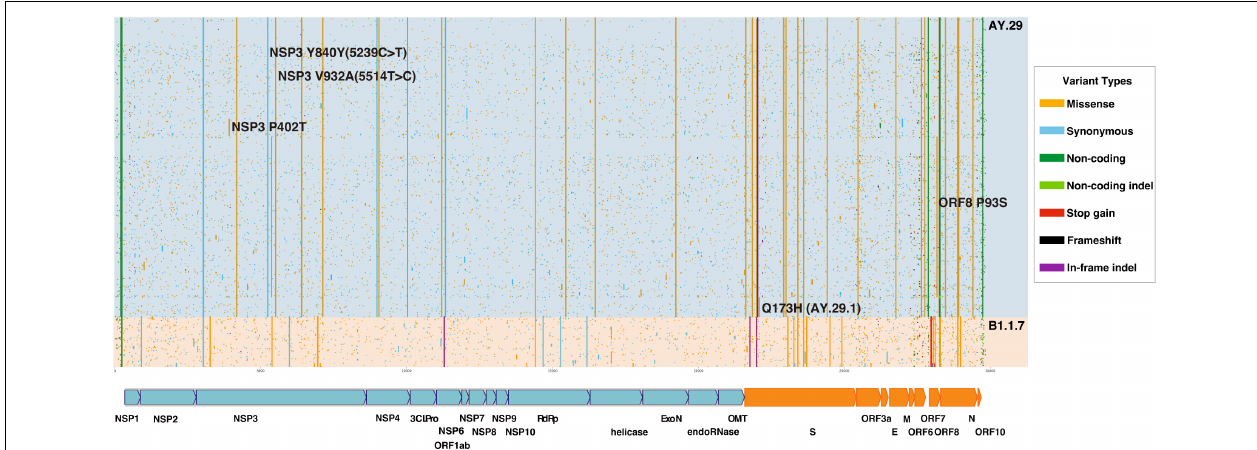
FIGURE 2 | Variant Analysis of SARS-CoV-2 genomes sampled in Tokyo, Japan between July 1st and September 10, 2021. AY.29 Delta substrain is dominant in the period. Variants are colored depending on the type of mutations (missense, synonymous, non-coding, stop-gained, and frameshift). 3CLPro, 3C like protease; del, deletion; delins, deletion–insertion; E, envelope protein; ExoN, 3’-5’ exonuclease; M, membrane glycoprotein; N, nucleocapsid phosphoprotein; NA, not applicable; NSP, non-structural protein; OMT, O -methyltransferase; ORF, open reading frame; RdRp, RNA-dependent RNA polymerase; SARS-CoV-2, severe acute respiratory syndrome coronavirus 2; S, spike glycoprotein; UTR, untranslated